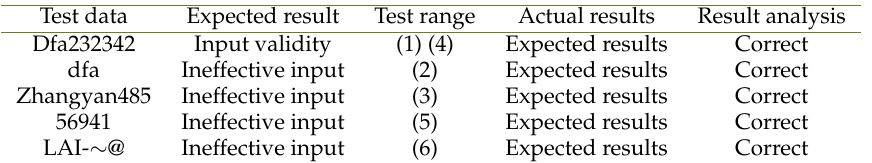
Table 2. User login test results.